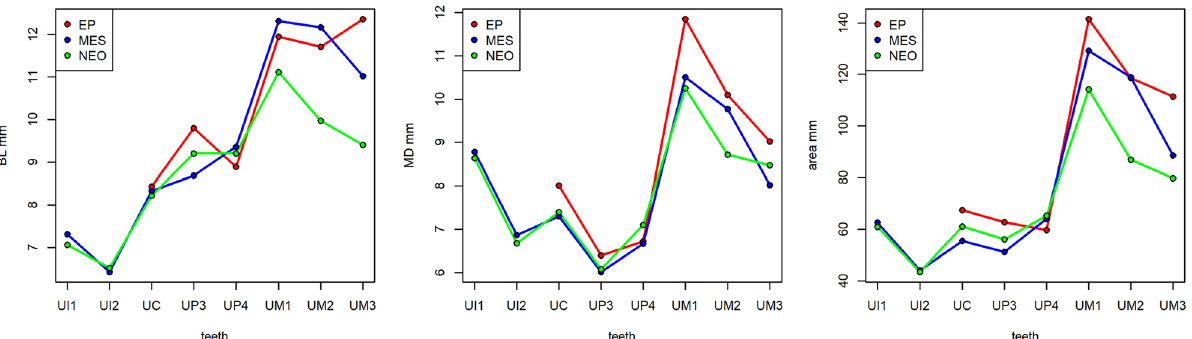
Figure 3. Variation of the mean crown diameters and area of the upper dentition through the periods. ( a ) Trend through time of the mean BL diameters; ( b ) Trend through time of the mean MD diameters, ( c ) Trend through time of the mean of the areas. EP = Late Epigravettian (n = 15), MES = Mesolithic (Sauveterrian and Castelnovian, n = 38), NEO = Early and Middle Neolithic (n =